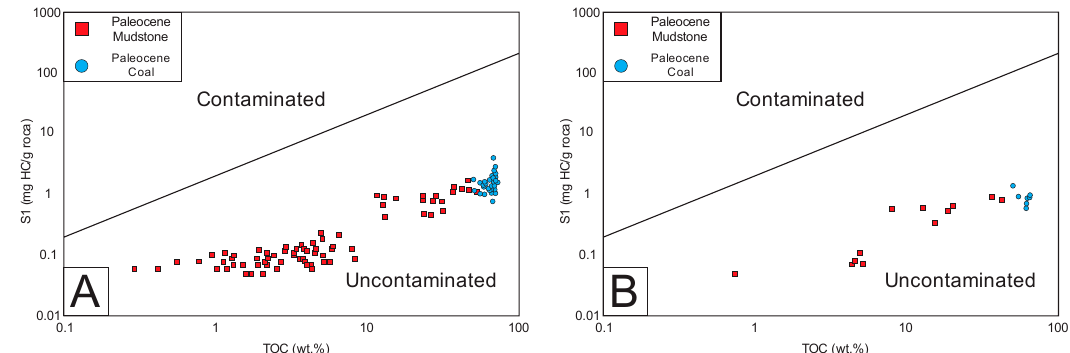
Figure 9. Cross plot of S1 versus TOC to indicate the origin of hydrocarbon in the Cerrejón Formation of the ( A ) ANH-CARRETALITO-1 and ( B ) ANH-CAÑABOBA-1 wells.